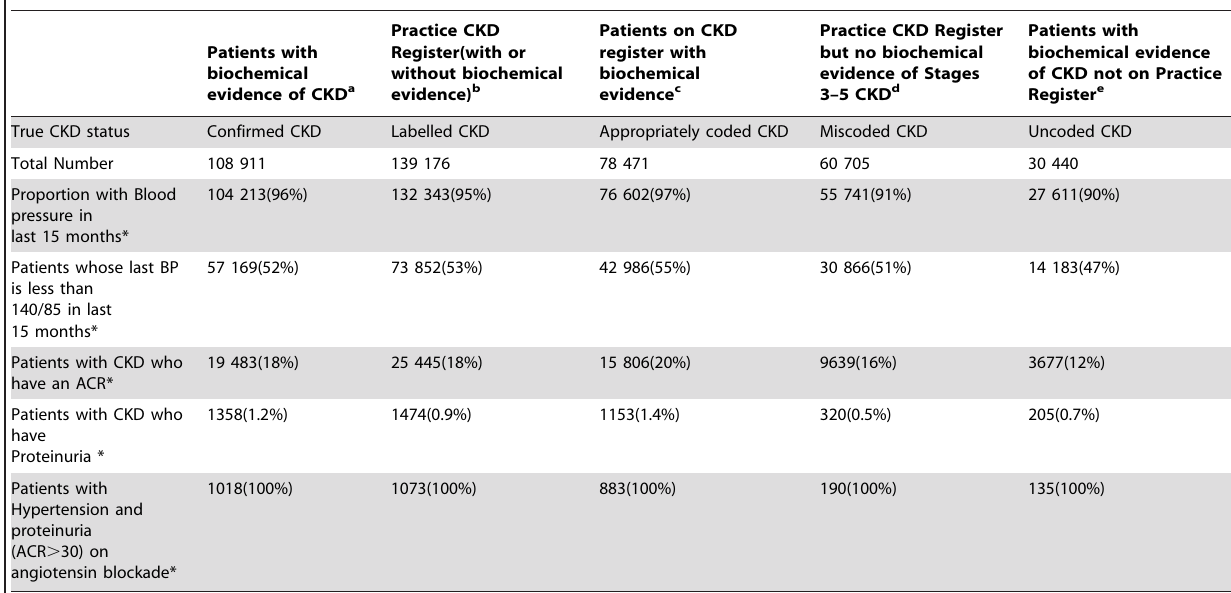
Table 3. CKD Management according to QOF standards between 1st January 2008 to 1st April 2009 +